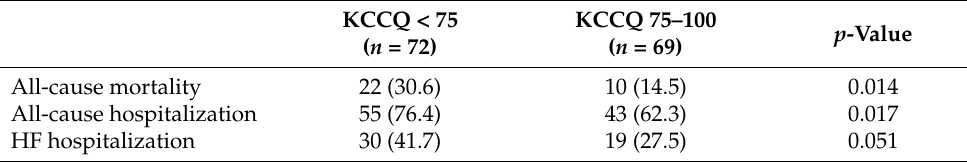
Table 3. Primary and secondary outcomes during